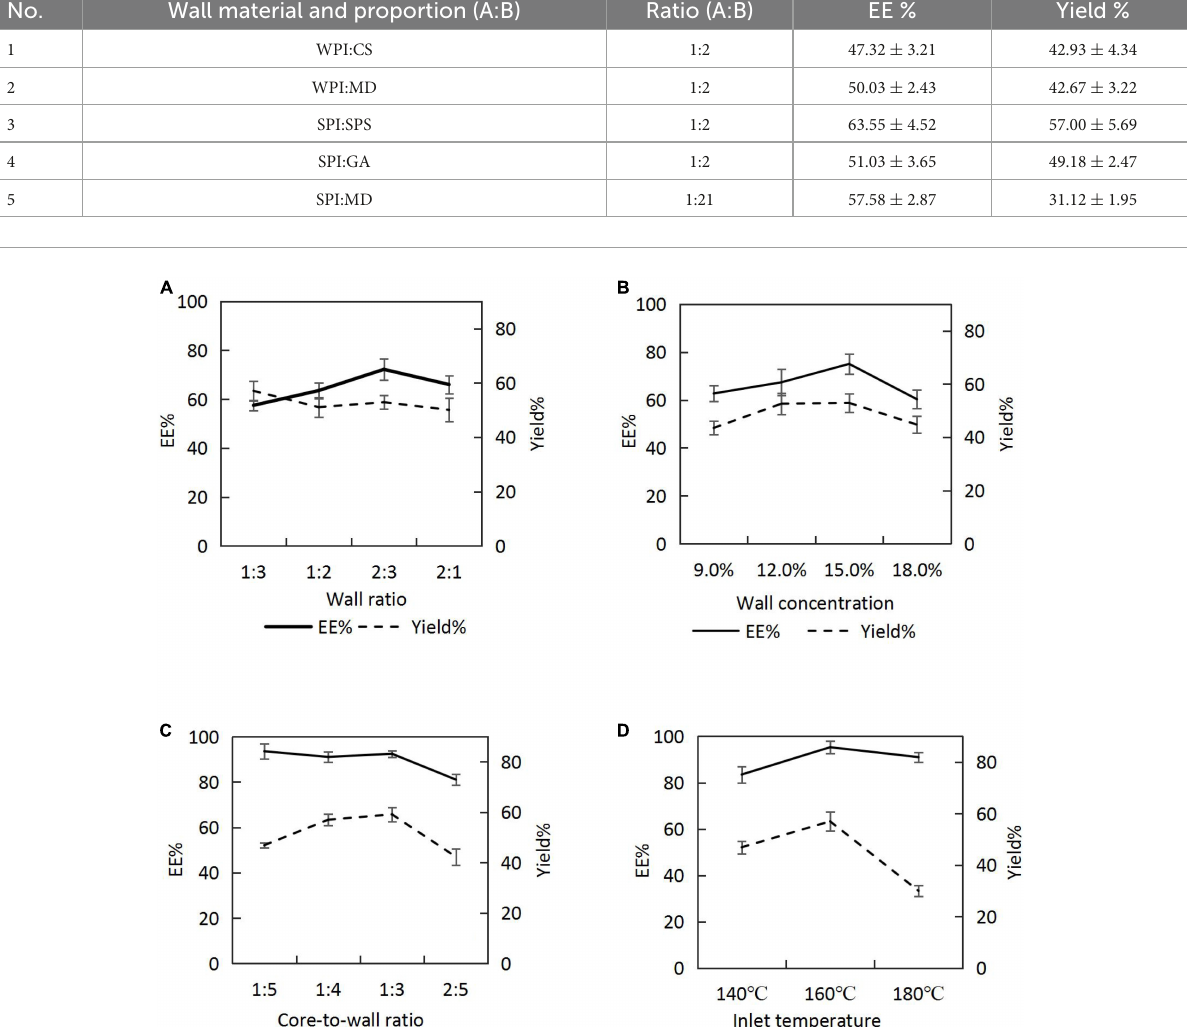
TABLE 3 Encapsulation efficiencies (EEs) and yields of microcapsules with different wall combinations. No. Wall material and proportion (A:B)